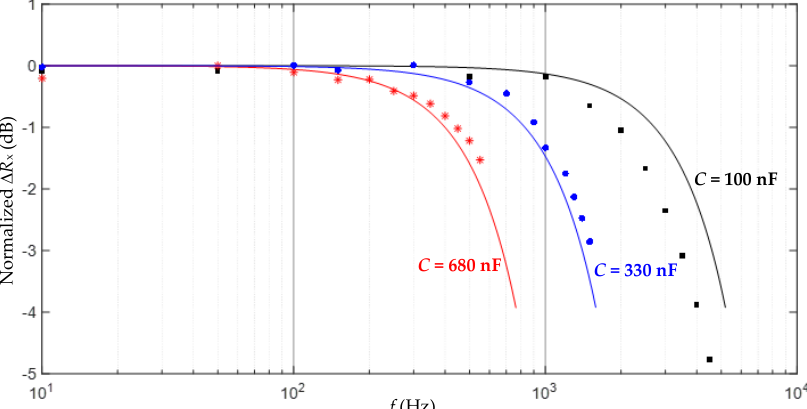
Figure 7. Results from Experiment A: the normalized frequency response for different values of C .